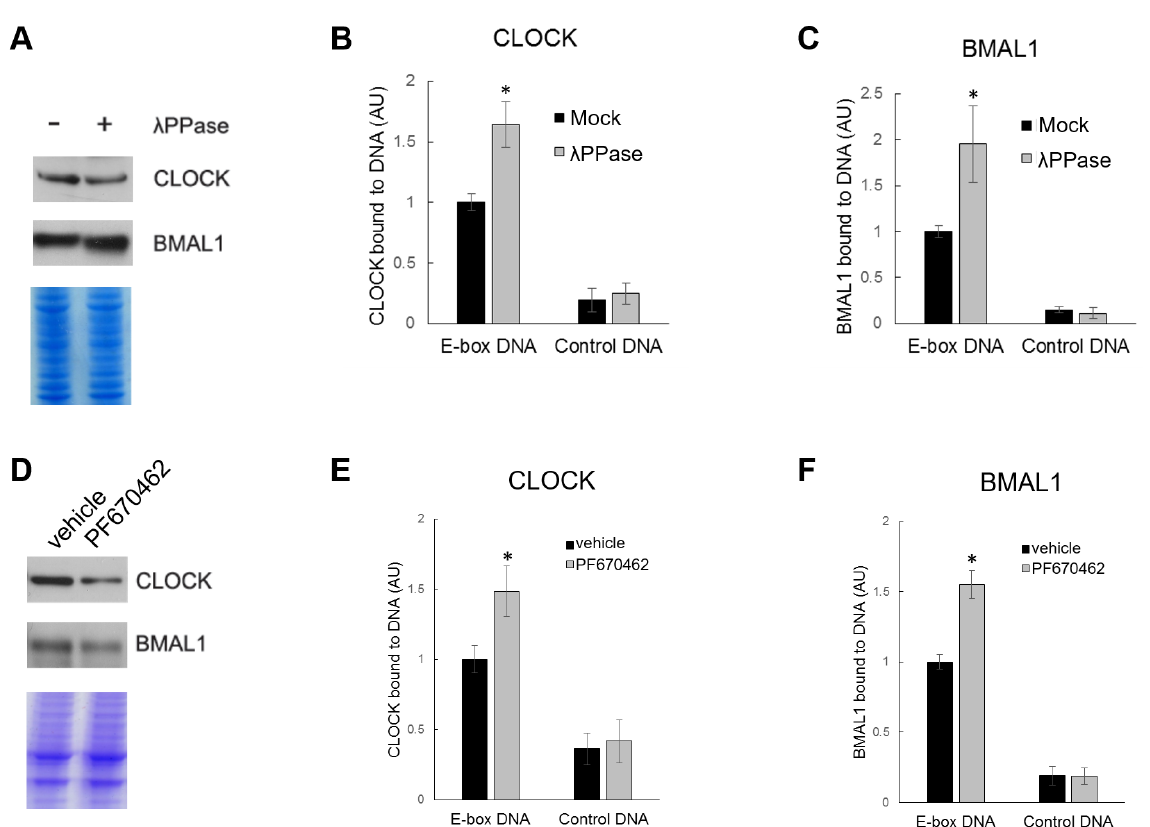
Figure 3. CPDBA captures CLOCK-BMAL1 modulation in tissue extracts and cells. ( A ) Liver nuclear extracts were treated with lambda phosphatase ( λ PPase) or mock buffer (Mock). Extracts were analyzed by SDS-PAGE/immunoblotting for the presence of CLOCK and BMAL1, and coomassie stained for loading controls. ( B , C ) CPDBA was applied to these extracts to measure binding of CLOCK ( B ) or BMAL1 ( C ) to E-box DNA. All data were normalized to the E-box DNA/mock treated condition (normalized to 1). (* P<0.0001, two-tailed, unequal variance). ( D ) Extracts were made from Hep-1c1c7 cells incubated with vehicle (DMSO) or 10 µM CKI ϵ / δ inhibitor PF670462. Extracts were analyzed by SDS-PAGE/immunoblotting for CLOCK and BMAL1, and coomassie stained for loading controls. ( E , F ) CPDBA was applied to these extracts to measure binding of ( E ) CLOCK and ( F ) BMAL1 to E-box DNA. All data were normalized to the E-box DNA/vehicle treated condition (normalized to 1). (*P=<0.0001, two-tailed, unequal